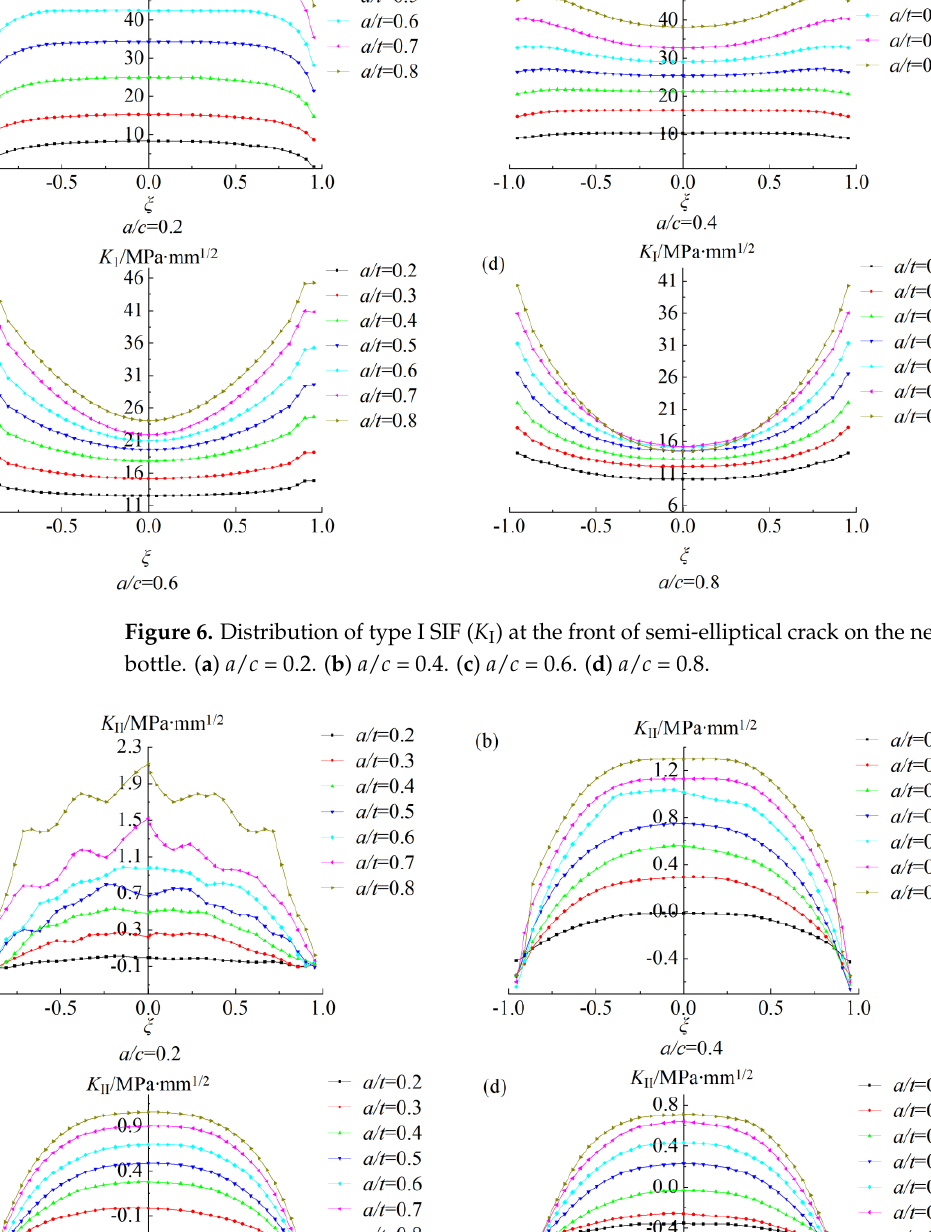
Figure 8. Distribution of type III SIF ( K III ) at the front of the semi-elliptical crack on the neck of the ampoule bottle. ( a ) a / c = 0.2. ( b ) a / c = 0.4. ( c ) a / c = 0.6. ( d ) a / c = 0.8.